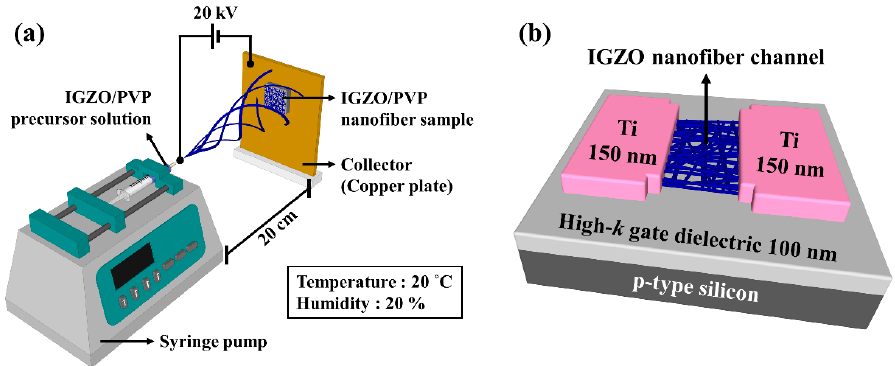
Figure 1. Schematic diagram of ( a ) electrospinning apparatus and ( b ) bottom-gate-type indium gallium zinc oxide (IGZO) nanofiber (NF) field-effect transistors (FETs) with high- k gate dielectrics.